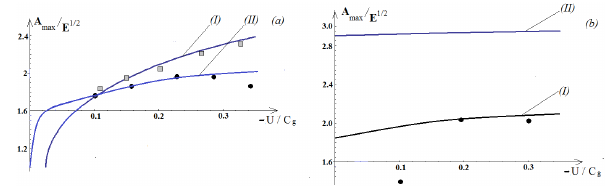
Figure 2. Nondimensional maximum wave amplitude as a func- tion of − U/C g , where C g is the group velocity of the carrier wave and E 1 / 2 is the local standard deviation of the wave enve- lope. (a) experiments conducted by Toffoli et al. (2013) for car- rier wave of period T = 0 . 8 s (wavelength λ ∼= 1m), initial steep- ness k 1 a 1 = 0 . 063, and frequency difference (cid:49)ω/ω 1 = 1 / 11, ini- tial amplitudes of side bands equal to 0.25 times the amplitude of the carrier wave. Solid dots show measurements made using a flume at Tokyo University and squares show results obtained at Plymouth University. Line (I) shows the prediction made using Eq. (2) (Tof- foli et al., 2013) while line (II) shows the model prediction. (b) case T11 in Ma et al. (2013) for carrier-wave frequency ω 1 = 1Hz, ini- tial steepness k 1 a 1 = 0 . 115, initial amplitudes of side bands equal to 0.05 times the amplitude of the carrier wave and frequency dif- ference (cid:49)ω/ω 1 = 0 . 44 a 1 k 1 . Solid dots show measurements. Line (I) shows the model prediction, while line (II) shows the prediction made using Eq. (2) (Toffoli et al.,